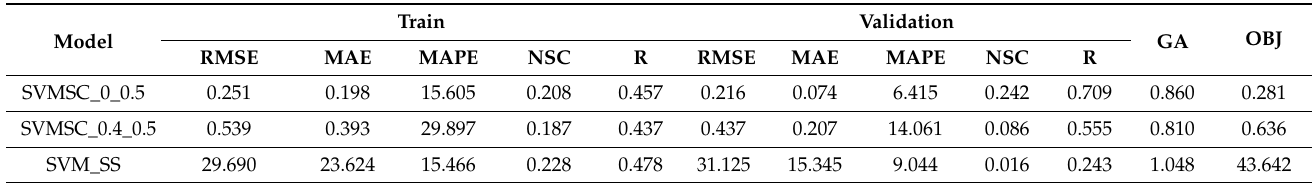
Table 6. Error metrics of the SVM models.